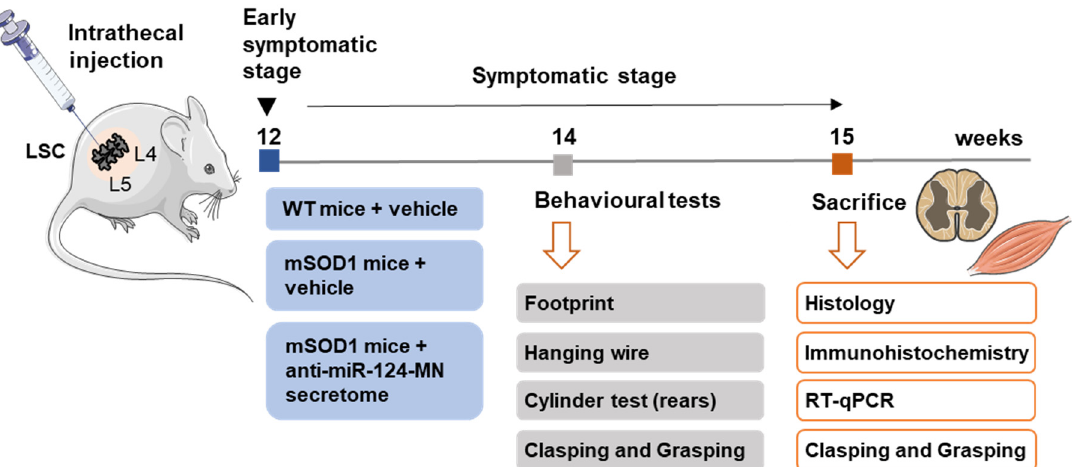
Figure 1. Experimental design. The wild-type (WT) and SOD1-G93A (mSOD1) mice were injected in the lumbar spinal cord [31] at the early symptomatic stage (12-week-old), either with the MN medium (vehicle, control group) or with the secretome from anti-miR-124-treated mSOD1 MNs (only the mSOD1 mice). Two weeks later, animals were behaviourally characterized through footprint, hanging wire, cylinder, clasping, and grasping tests. At 15 weeks of age, the animals were sacrificed, and the lumbar spinal cord [31] and gastrocnemius muscle were isolated for histological and immunohistological analysis, as well as for reverse transcription quantitative real-time polymerase chain reaction (RT-qPCR) and western blot evaluations. This Figure was partially created with Servier Medical Art (smart.servier.com).